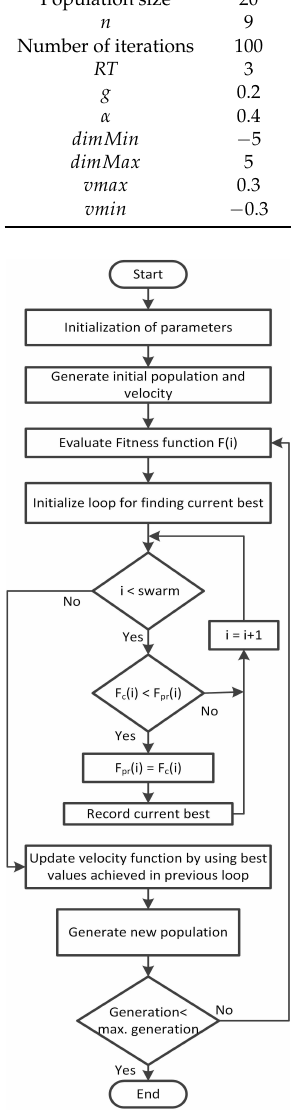
Figure 6. Flow chart of